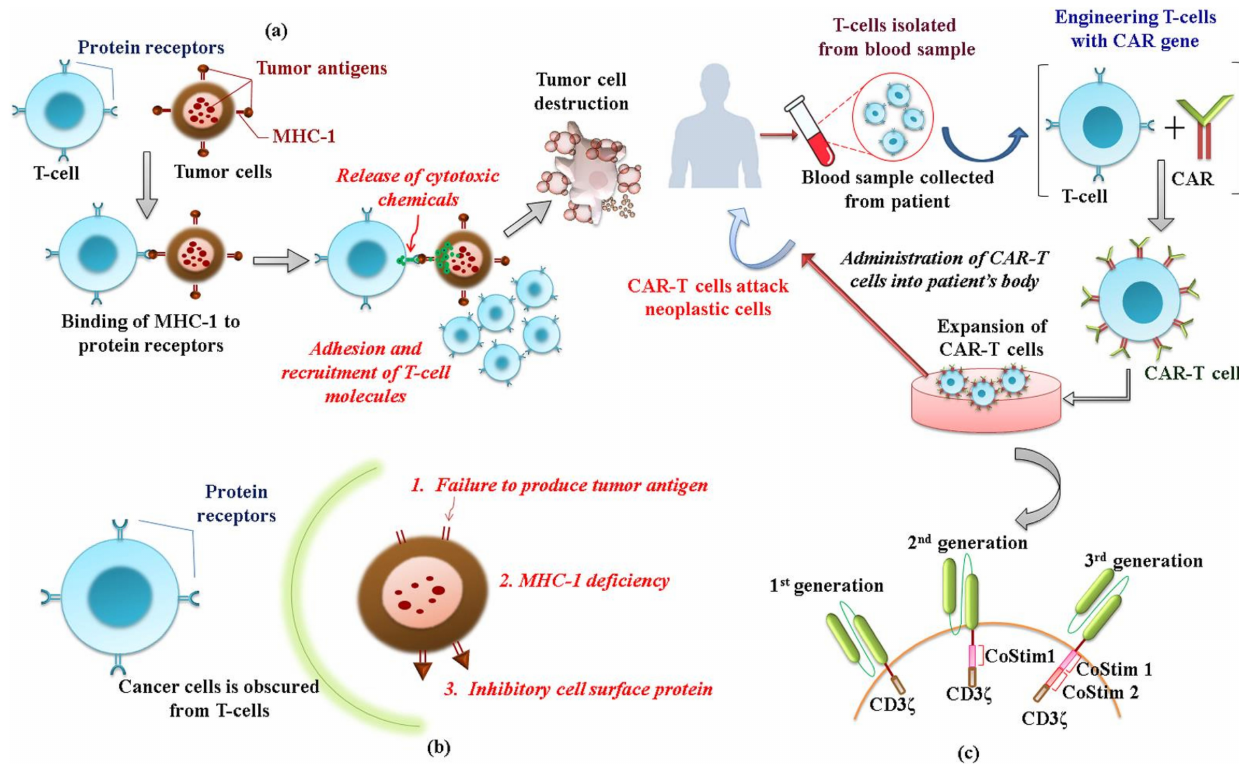
Figure 3. ( a ) Active immune surveillance against tumor cells. APCs capture TAAs released from tumor cells because of necrosis to its surface through the MHC. The binding of TAA-linked APC to the specific TCR of CD8+ T cells leads to its activation of the effector T-cell phenotype and CTL. ( b ) Immune evasion strategies of tumor cells. Tumor cells escape from T cell-mediated anticancer immunosurveillance mainly via the inhibition of production and presentation of TAA, deficient expression of MHC-1, and expression of immune inhibitory surface proteins. ( c ) CAR-T cell therapy. T cells isolated from the patient’s blood were transduced with a CAR gene for modified antigen receptors that can specifically target a tumor-specific antigen and destroy it without the need of MHCs (unlike T cells) and immunization (unlike vaccine). The expanded and screened CART-T cells are reinjected into the patient. Structurally, CAR is made of an extracellular antigen-binding domain of a tumor-specific antibody connected to an intracellular domain comprising CD3 of TCR via a transmembrane hinge region. Structural modifications of the intracellular domain with a costimulatory domain of CD28 results in the formation of second-generation CARs, whereas third-generation CARs comprise two co-stimulatory